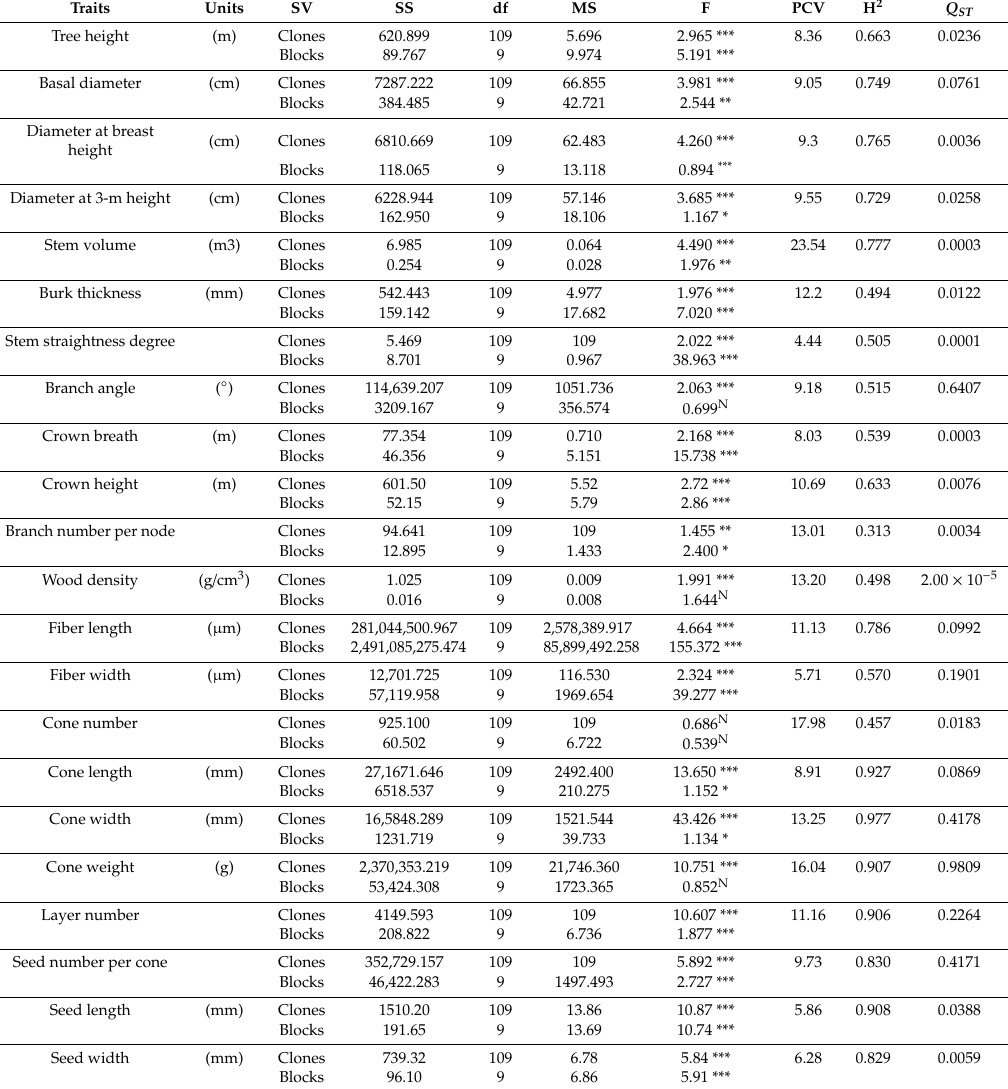
Table 1. Descriptive statistics and variation parameters of 110 Pinus koraiensis clones grown in the Naozhi seed